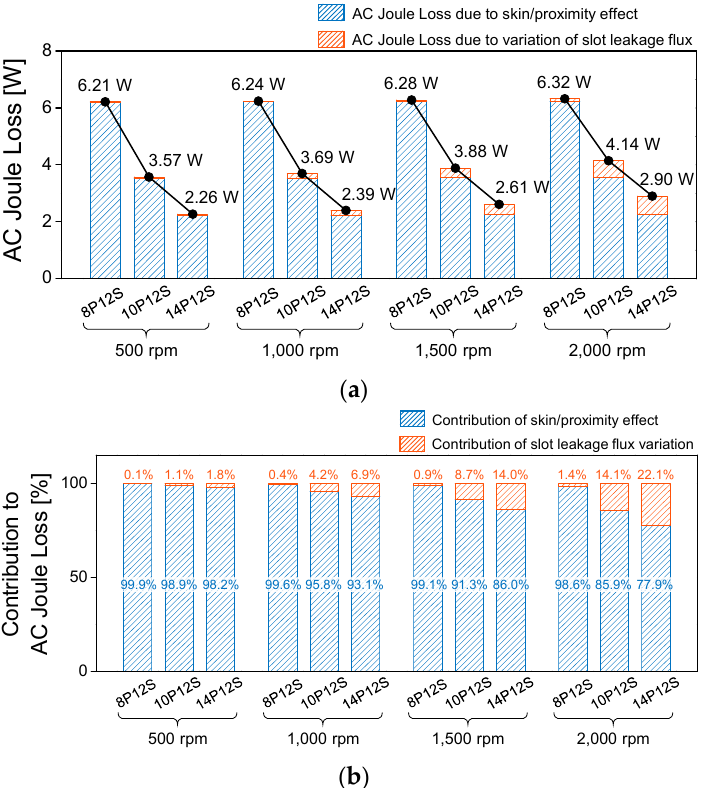
Figure 7. Effect of rotor poles on AC Joule loss. ( a ) AC Joule loss and ( b ) contribution to AC Joule loss by each cause at various numbers of poles and rotational speeds.